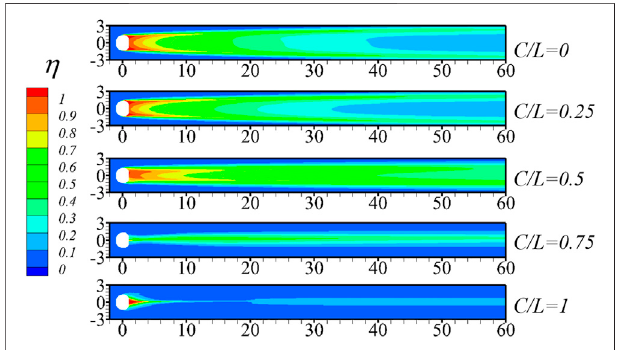
FIGURE 13 | Spanwise average ef fi ciency in M (cid:2) 2.5 condition.